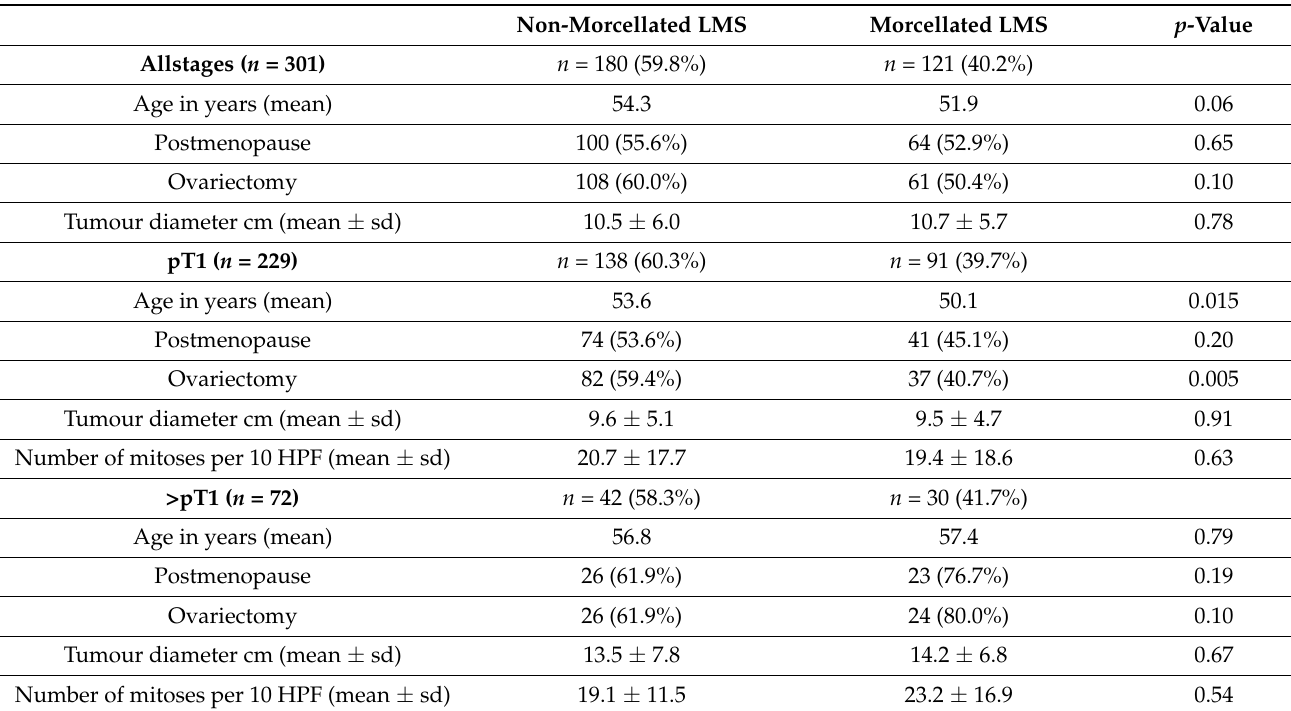
Table 1. Preoperative characteristics of patients without and with morcellation. Non-Morcellated